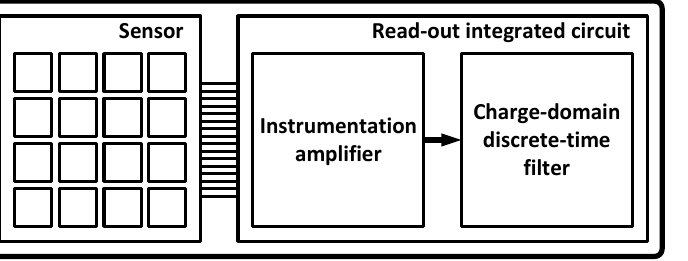
Figure 1. Read-out integrated circuit as an application of the proposed charge-domain discrete- Figure 1. Read ‐ out integrated circuit as an application of the proposed charge ‐ domain discrete ‐ time time filter. filter.